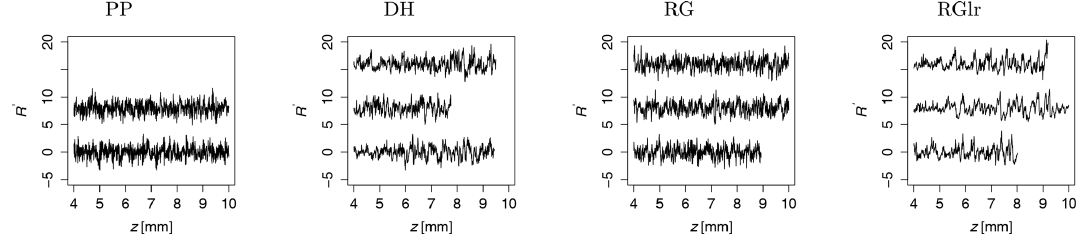
Figure 7. Detrended snow hardness profiles of four different snow types, PP, DH, RG and RGlr. For the snow type RGlr, we only show the samples RGlr4, RGlr5 and RGlr6, as described in Table 1. The detrended profiles R (cid:48) (z) of each snow type are shifted vertically for better visualization.